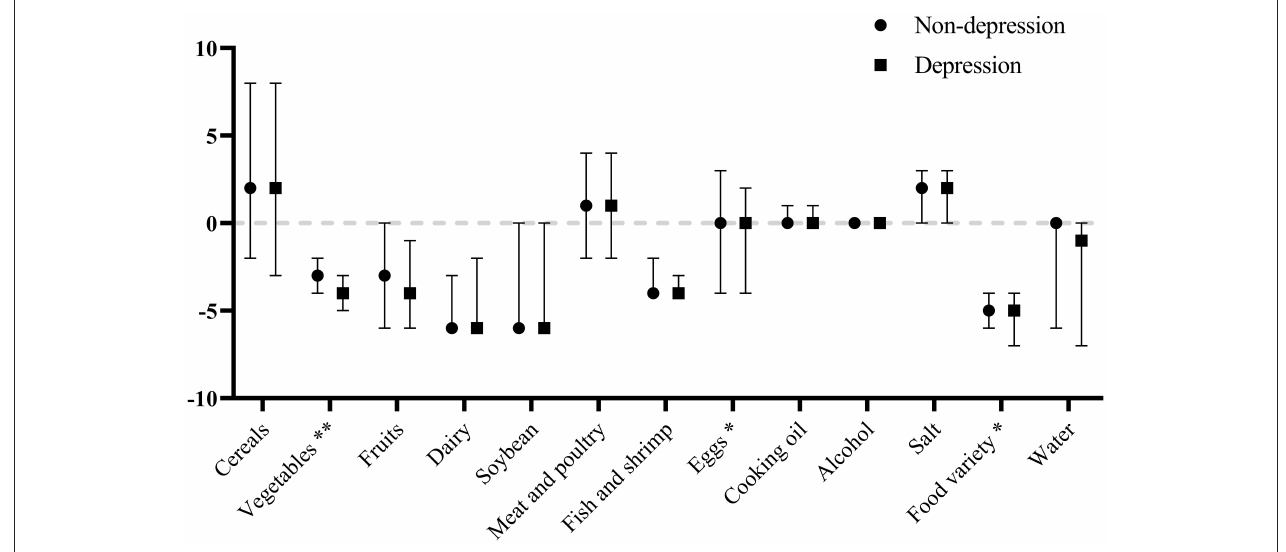
FIGURE 3 | Comparison of scores [Median (25th, 75th)] for the DBI components by depression status. ** P < 0.01; * P < 0.05.